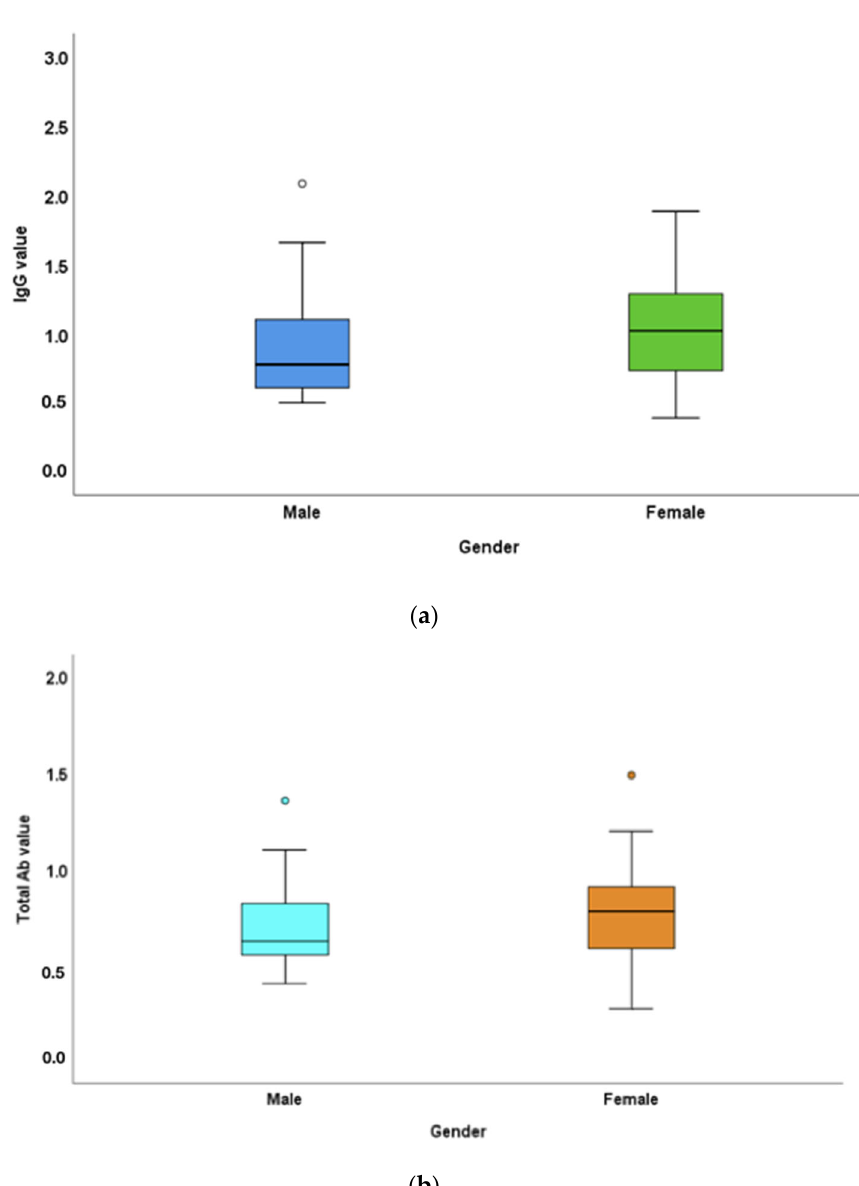
Figure 1. Mean IgG and total antibody titre difference between the male ande female populations in the study: ( a ) IgG titres in males and females in the study were 0.93 ± 0.43 and 1.07 ± 0.39 µ g, respectively. ( b ) Total antibody titres in the male and female populations in the study were 0.72 ± 0.24 and 0.76 ± 0.24 µ g, respectively. Females had higher IgG levels and total antibody levels compared to those of males. The difference between male and female IgG levels was statistically significant ( p ‐ value < 0.05).